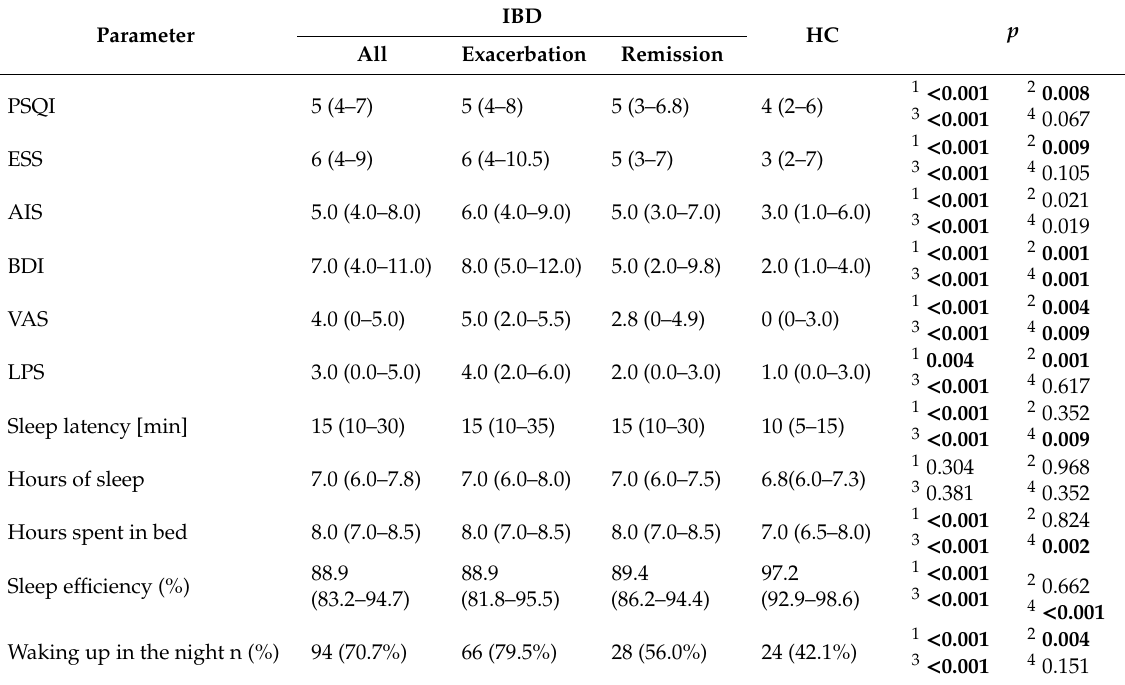
Table 2. Comparison of the results of questionnaires / scales between study